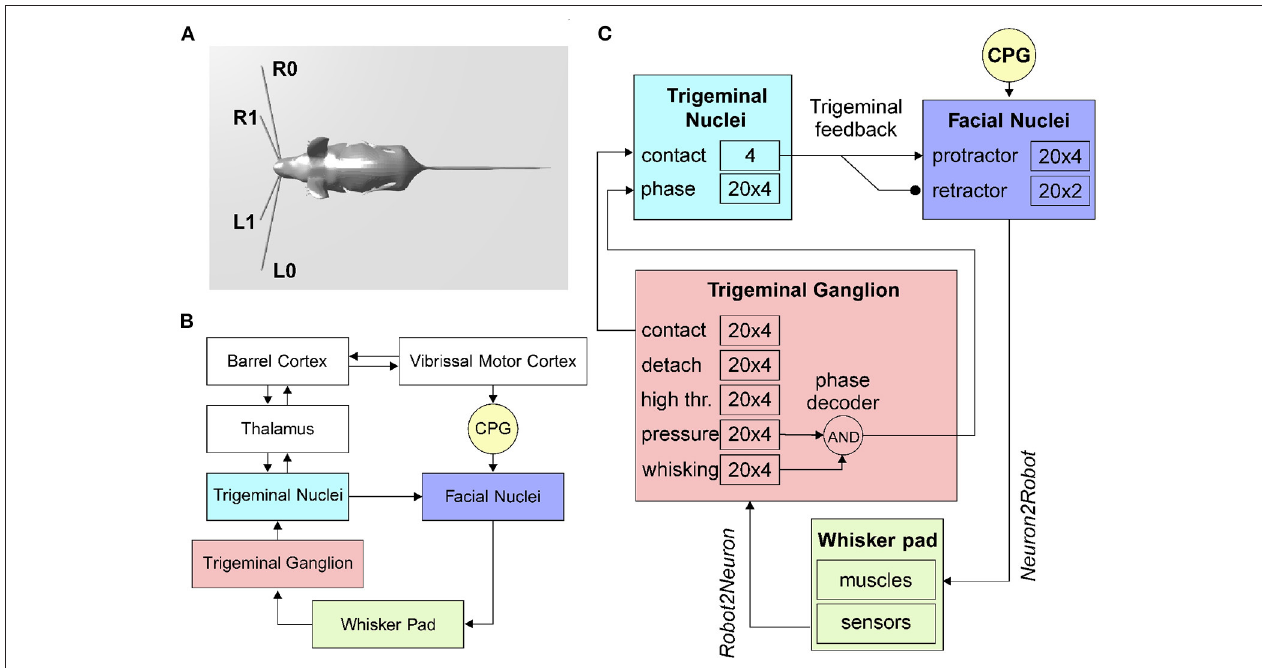
FIGURE 1 | The rodent whisker system. (A) Virtual robotic mouse implemented in the NRP, with two whiskers per side. L0 and R0 are the lower left and right whiskers, L1 and R1 are the upper whiskers. (B) Block diagram of the rodent whisker system, including sensory and motor pathways, and its integration with higher-order areas (thalamus and cortex). (C) SNN implementation of the mouse peripheral whisker system; numbers in each block represent the size of the neural populations included in that brain region. Arrows represent excitatory connections, circles inhibitory